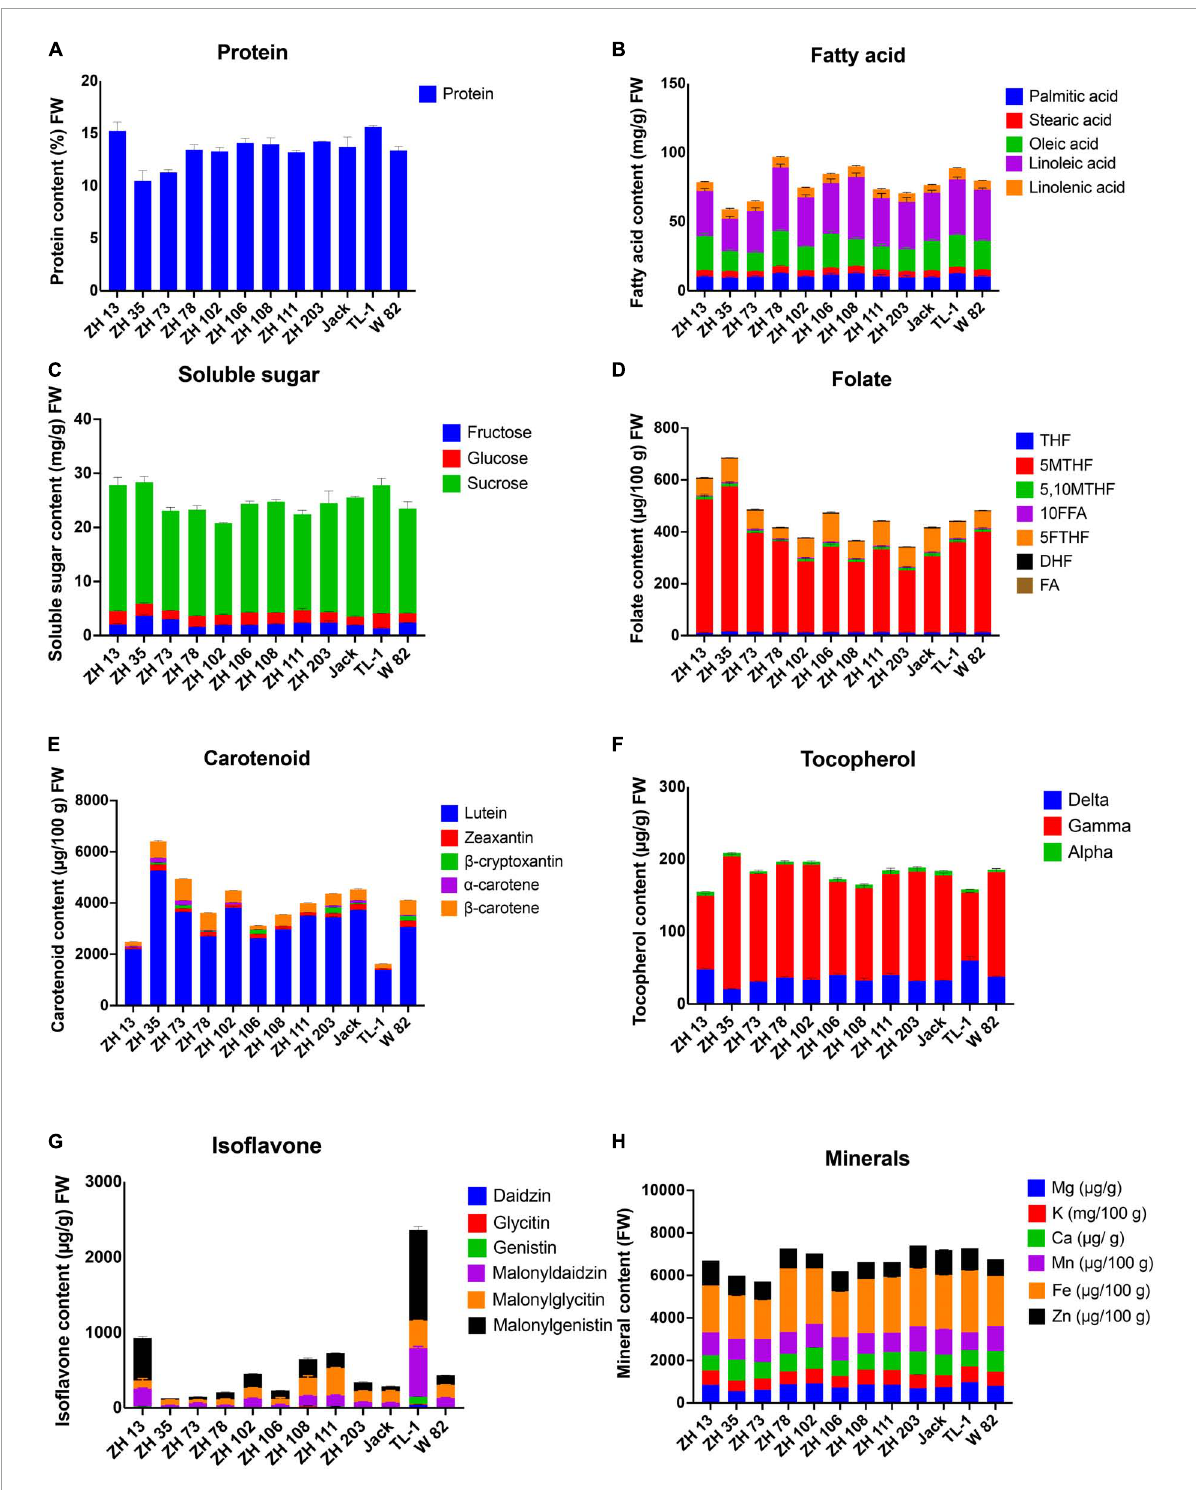
FIGURE2 Nutritional composition of maodou (FW). (A) Protein, (B) fatty acids, (C) soluble sugars, (D) folates, (E) carotenoids, (F) tocopherols, (G) isoflavones, and (H)